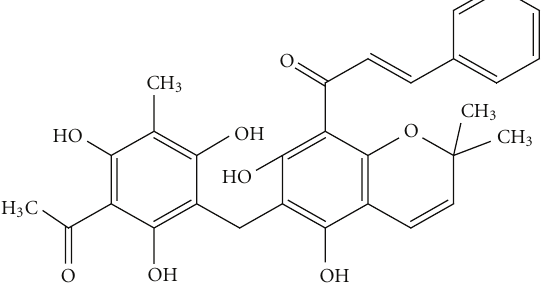
Figure 2: The Rottlerin